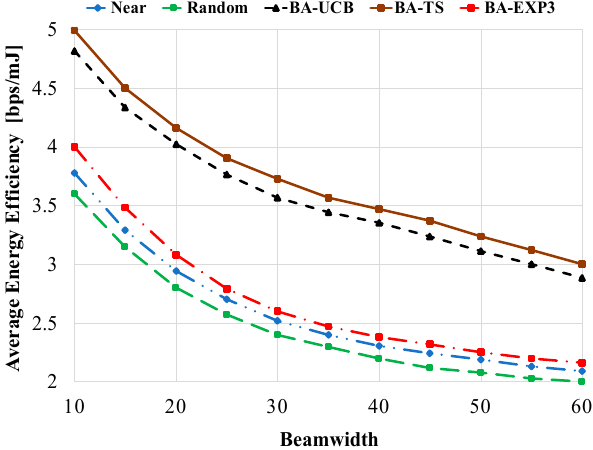
Figure 9. Average energy efficiency against beam-width using access UAVs of 40 and gateway UAVs of 20.